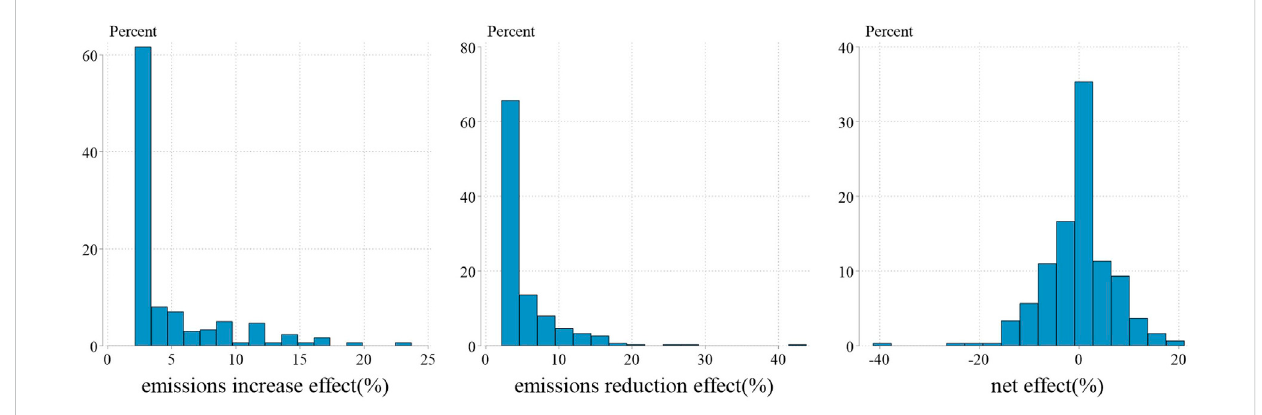
FIGURE 2 Distribution of the emissions increase effect, emissions reduction effect, and net effect of the digital